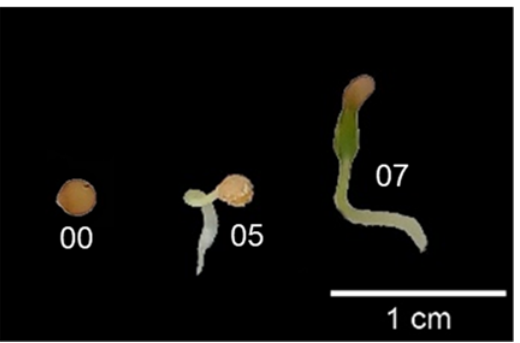
Figure 5. Main stage 0 (germination) for slender nightshade seedlings ( Solanum nigrescens Mart. and Gal.), based on the BBCH scale: 00: dry seed; 05: radicle emerged from seed; 07: hypocotyl with cotyledons breaking through seed coat. Photos by Sara Monzerrat Ramírez-Olvera.